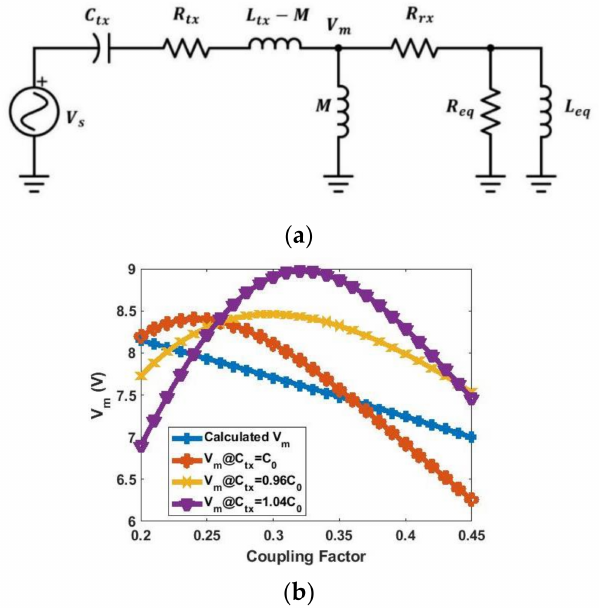
Figure 16. ( a ) Proposed equivalent circuit model of wireless-charging hanger system with RX replaced by equivalent Class-E rectifier circuit model; ( b ) simulated V m with different C tx .